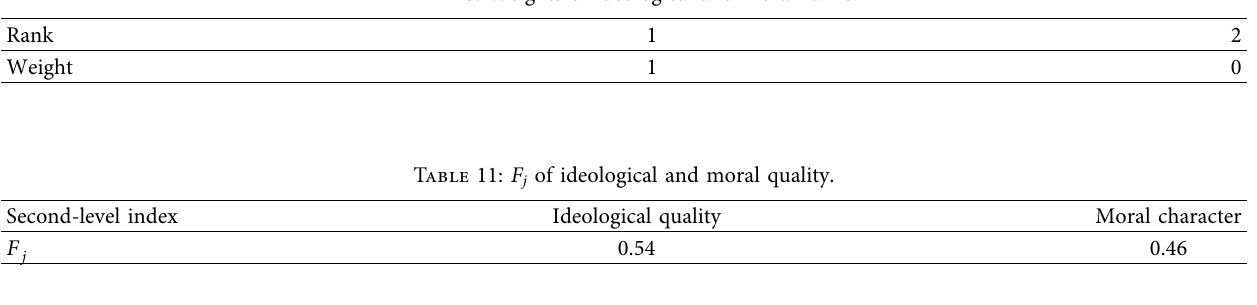
Table 10: Weights of ideological and moral ranks.